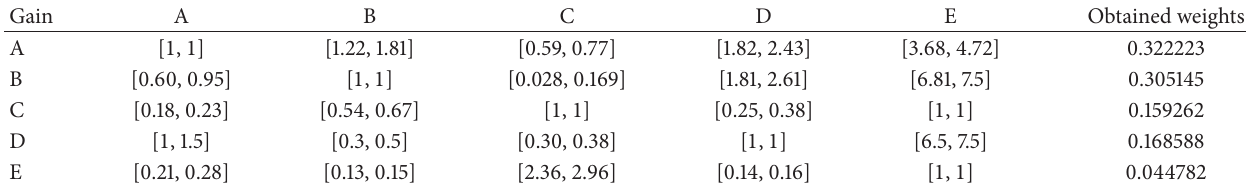
Table 19: The interval approximation options concerning gain subcriteria.